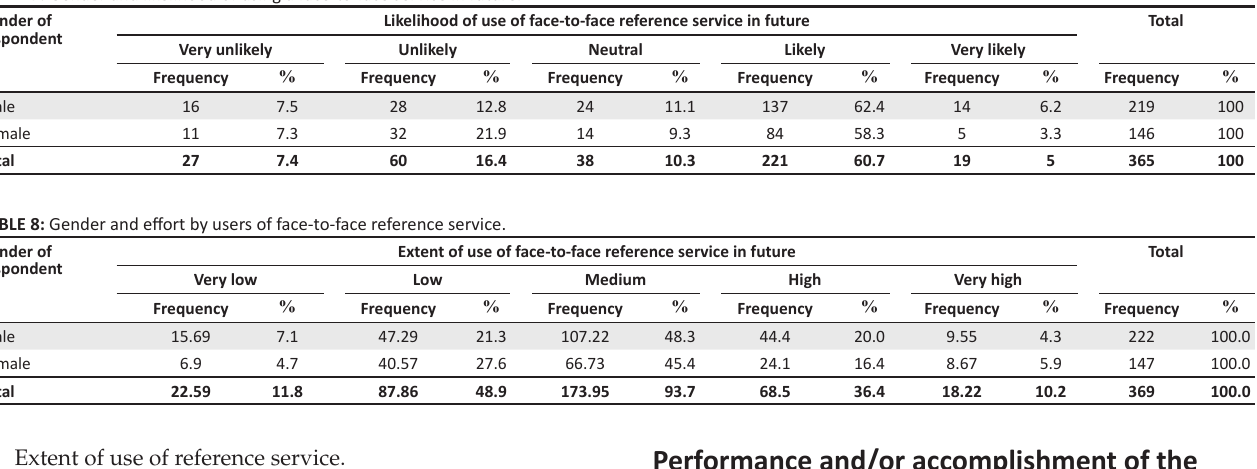
TABLE 7: Gender and likelihood of using a face-to-face service in future. Gender of respondent